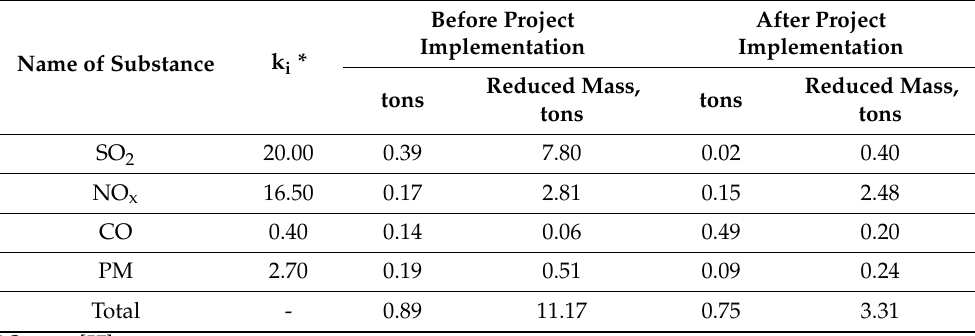
Table 4. Reduced mass of harmful substance emissions before and after project